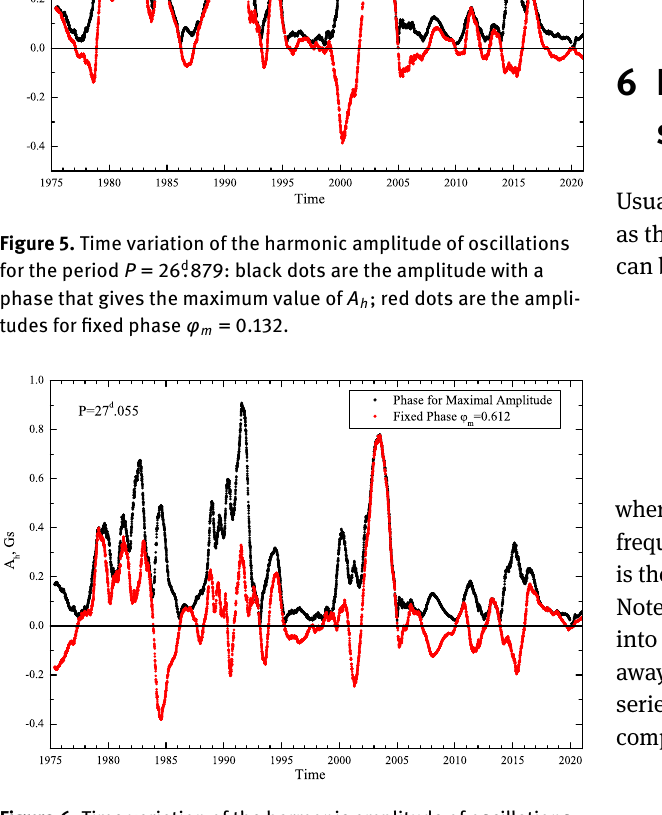
Figure 6. Time variation of the harmonic amplitude of oscillations for the period P = 27 d .055: black dots are the amplitude with a phase that gives the maximum value of A h ; red dots are the ampli- tudes for fixed phase φ m =